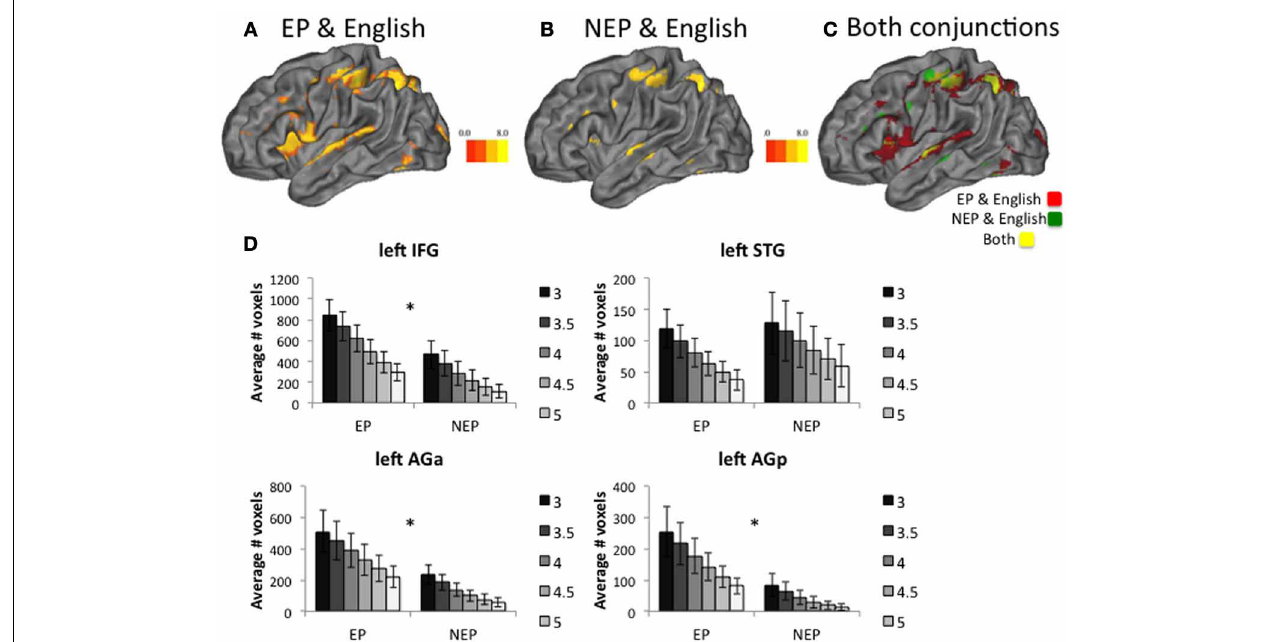
FIGURE 4 | Conjunction Analysis. Learners of both languages recruit many overlapping voxels with English (A,B) . Overlaying both conjunctions shows differences in the EP and English conjunction (red) and NEP and English conjunction (green) as well as shared regions (yellow) (C) . Group t -tests reveal that the number of jointly recruited voxels (new language and English)